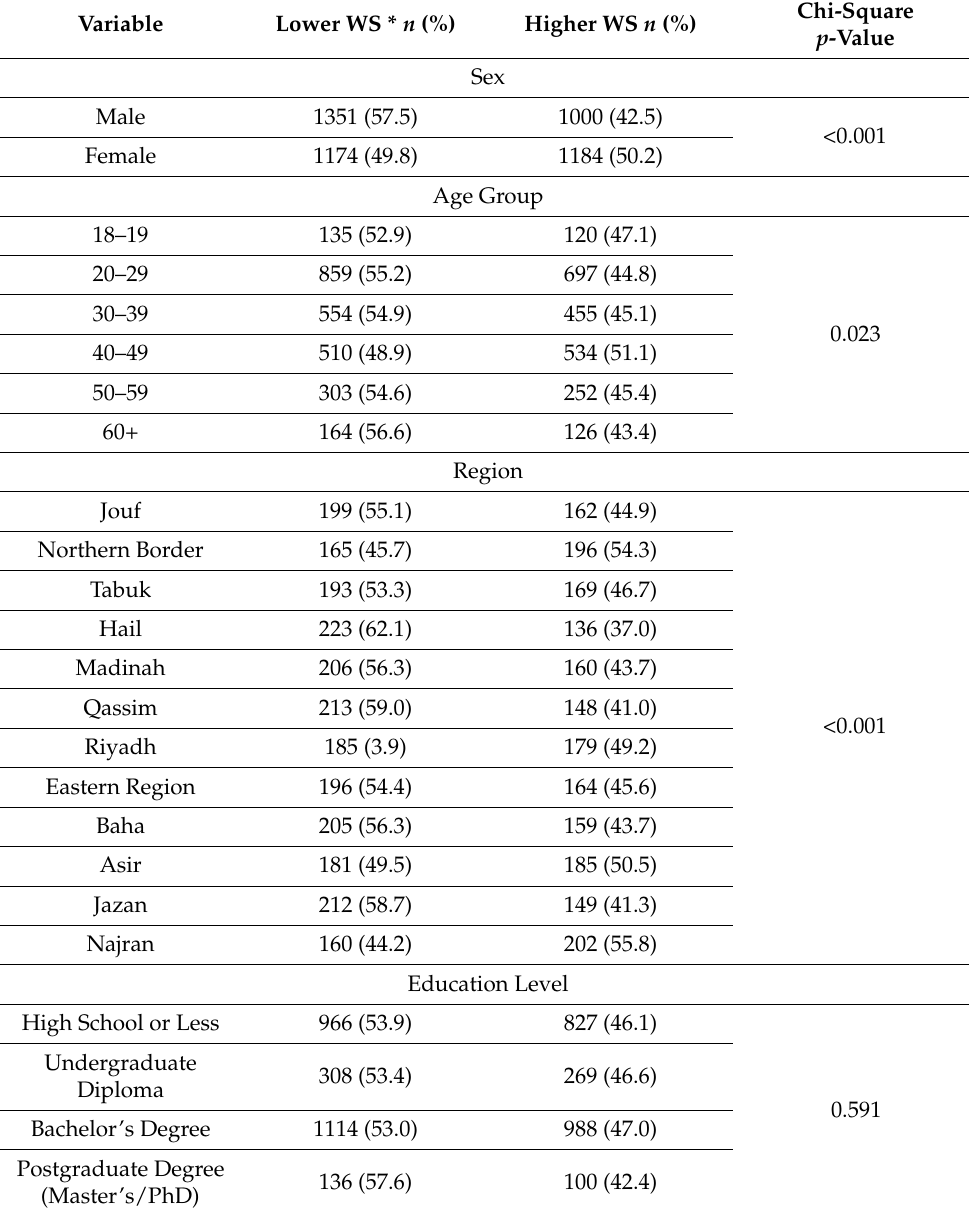
Table 2. Prevalence of weight stigma by participant demographic characteristics ( n =